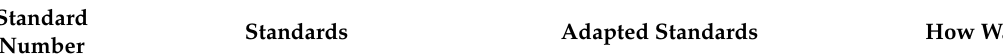
Table A2. How the standards were